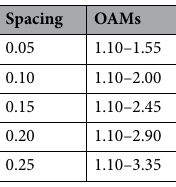
Table 1. 5 mode intervals and the corresponding 10 OAM modes.